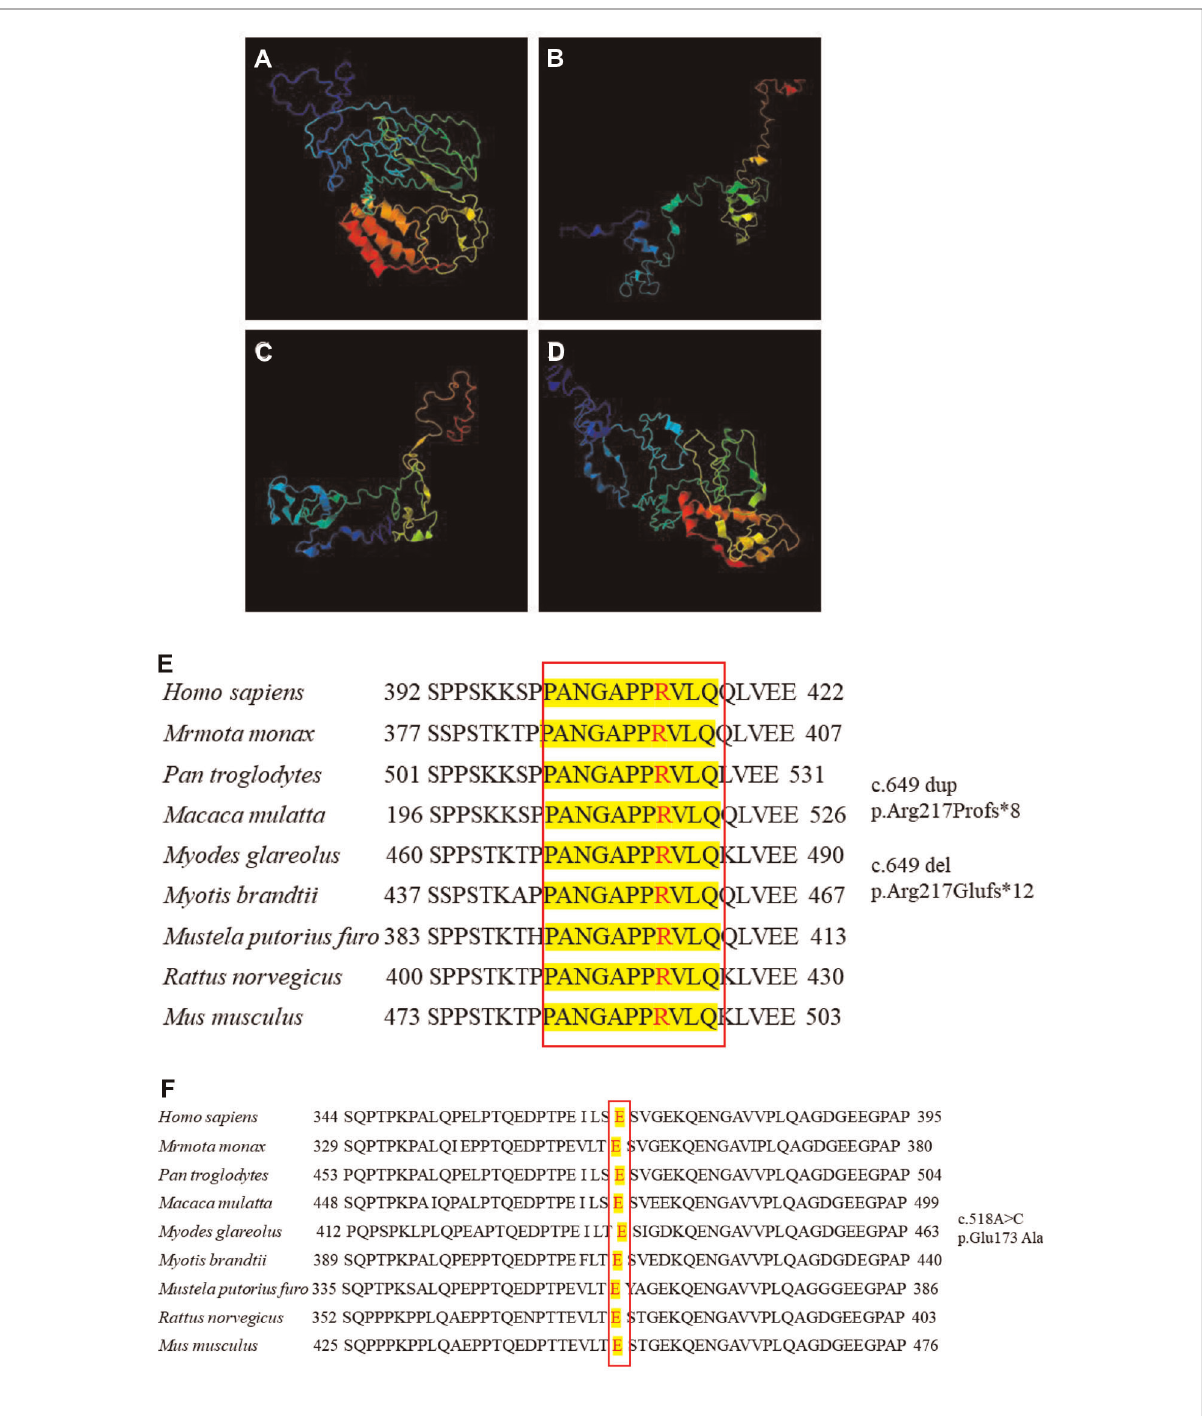
FIGURE 2 Three-dimensional structure of proline-rich transmembrane protein 2 (PRRT2). ( A ) Wild-type protein. Frameshift mutation ( B ) c.649 dup and ( C ) c.649 del. ( D ) Missense mutation c.518A>C. Conservation studies of ( E ) c.649 and ( F ) c.518 on Homo sapiens , Marmota monax , Pan troglodytes